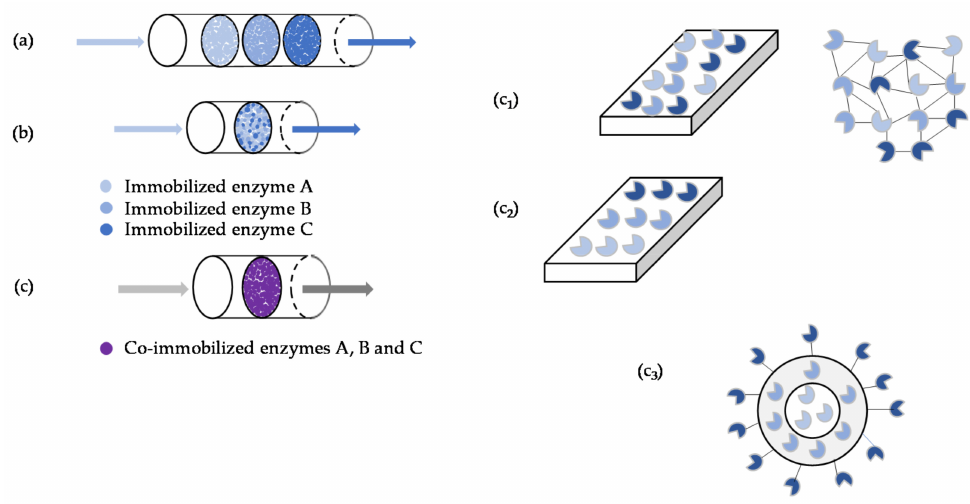
Figure 3. Different methodologies for multi-enzyme immobilization: ( a ) stepwise immobilization, ( b ) mixed immobilization, ( c ) co-immobilization, ( c 1 ) random co-immobilization, ( c 2 ) compartmentalization and ( c 3 ) positional